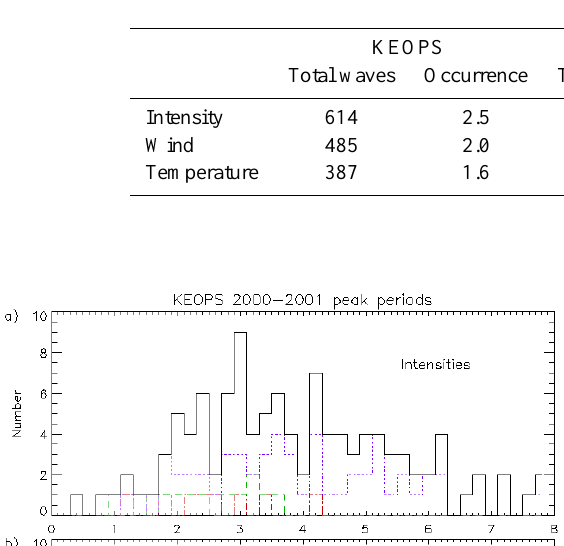
Table 1. Occurrence of gravity waves per night, for each site, over all seasons of data for the intensities, winds and temperatures.